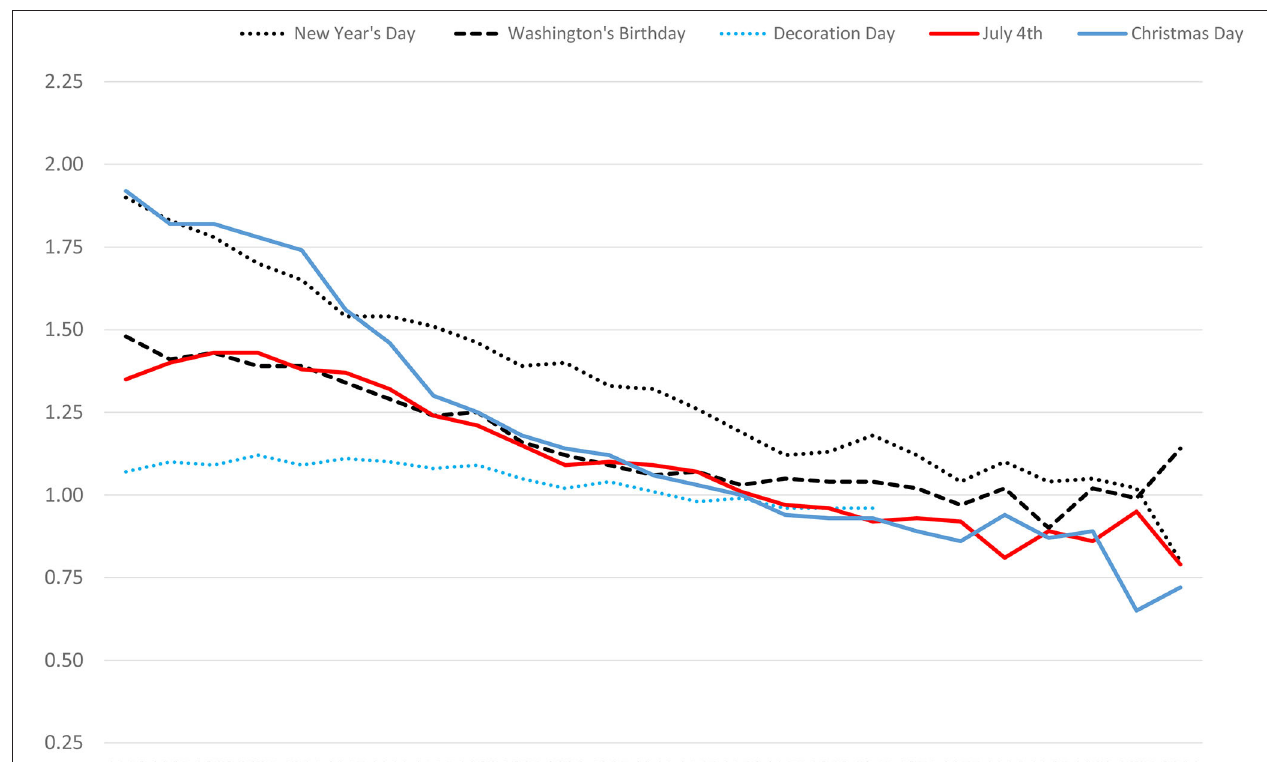
FIGURE 3 | Historical changes in birthday selection for five major U.S.